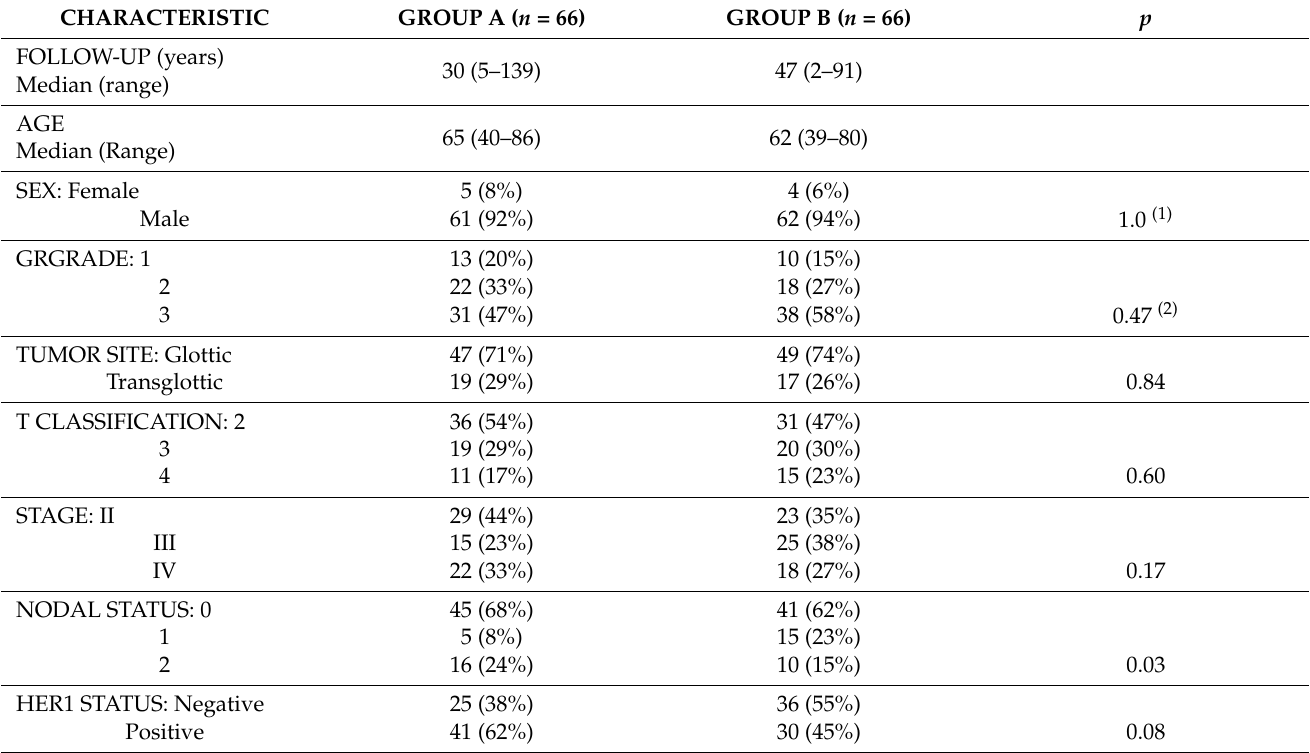
Table 1. Baseline characteristics of the studied